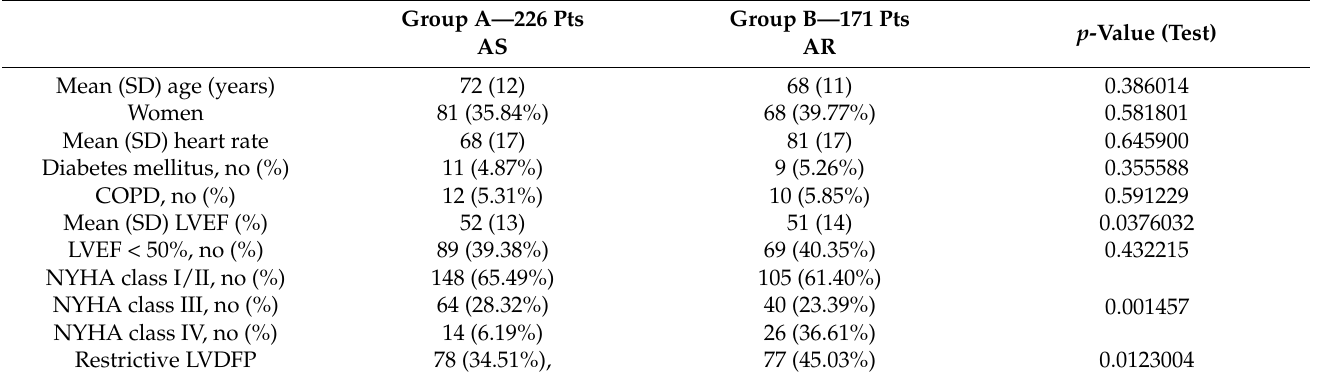
Table 1. Baseline patients’ characteristics—AS and AR